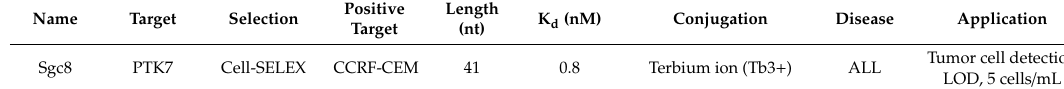
Table 2. Aptamers in preclinical